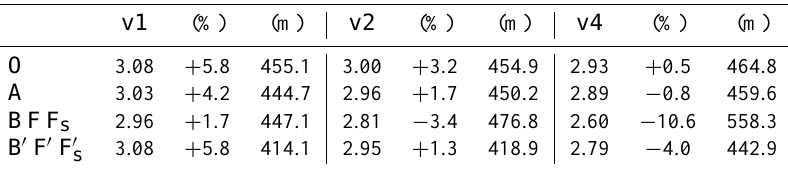
Table 2. Simulated ice-sheet volume ( × 10 15 m 3 ), the percentage relative to the present-day observed volume 2 . 91 × 10 15 m 3 , and the root mean square of the difference in the thickness relative to the observation (m). Configurations correspond to the results for v1 (using “stan- dard” sliding coefficients), v2 (2 × ), and v4 (4 × ) are shown. The volumes of other experiments such as D , E , etc. are identical to the observed value by